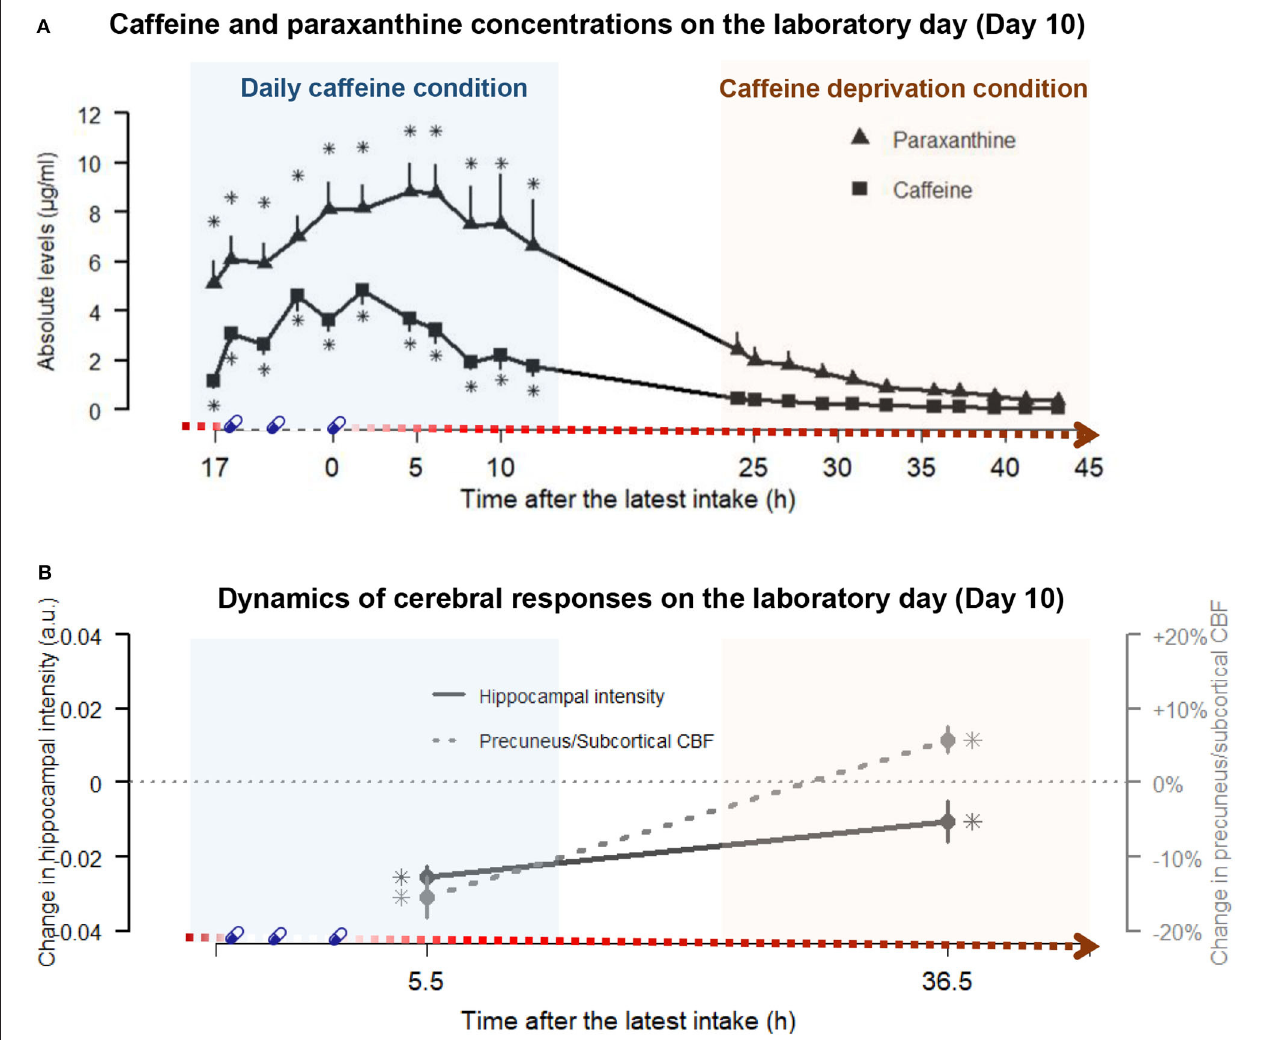
FIGURE 2 | The paraxanthine and caffeine concentrations at the respective time points and the dynamics of cerebral responses on the laboratory day (day 10) in daily caffeine and caffeine deprivation conditions, respectively. (A) juxtaposes the profiles of caffeine (squares) and paraxanthine (triangle) in caffeine condition (blue shading, left panel) and after the caffeine deprivation (red shading, right panel) against the duration after the latest dose of caffeine on the x -axis. Echoing Figure 1 , the gradient red arrow parallel to the x-axis schematically indicates the duration of the caffeine deprivation. The times of treatments are denoted by blue capsules. Detailed statistics are addressed in the Result section. In brief, the main effects of conditions indicated that paraxanthine levels remained elevated throughout the caffeine and the caffeine deprivation conditions compared to placebo, while caffeine levels were elevated in caffeine conditions but did not significantly differ from placebo in the deprivation. Asterisks (*) indicated the time points exhibiting significantly elevated levels compared to placebo by a post-hoc analysis on the significant Condition x Sample interaction. (B) illustrates the magnitudes of the changes in hippocampal GM intensity (straight line) and the precuneus + subcortical CBF quantity (dashed line) during daily caffeine intake and after caffeine deprivation, relative to placebo (dotted horizontal line). The asterisks indicated significant differences compared to placebo. Detailed statistics are addressed in the Results section.